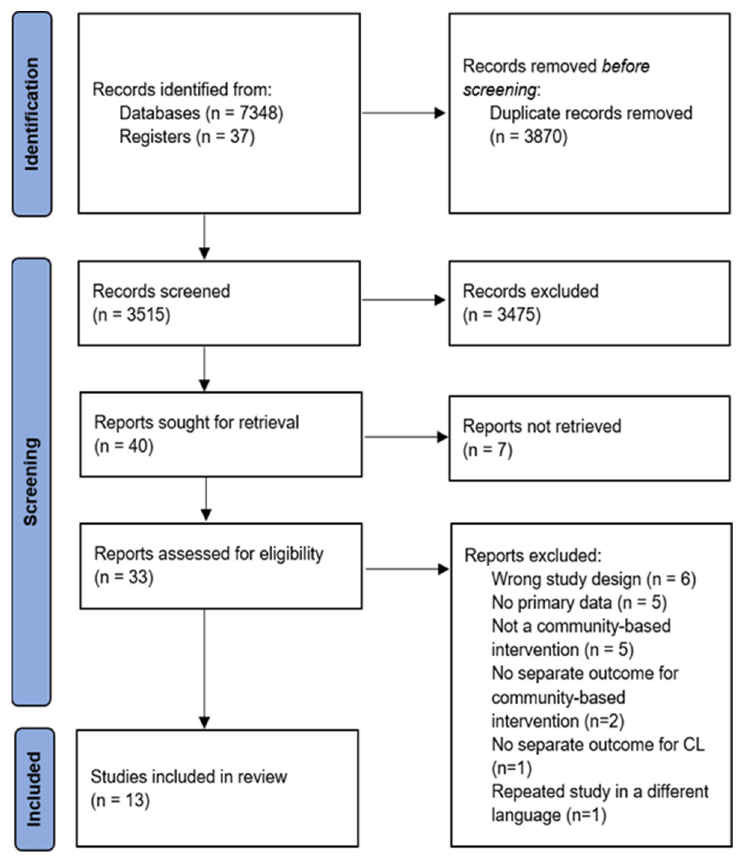
Figure 1. PRISMA flow chart of screening process and selected studies.